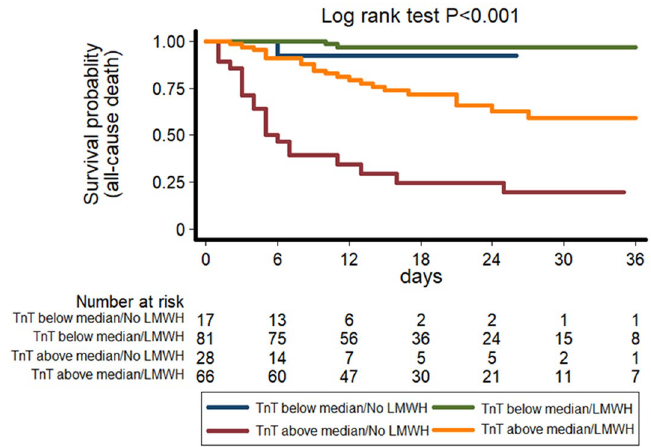
Figure 2. Kaplan–Meier survival curves for all-cause death according to hsTnT levels above and below median and the presence or absence of heparin treatment during hospitalization (green line = TnT below median, heparin; blue line = TnT below median, no heparin; orange line = TnT above median, heparin; red line = TnT above median, no heparin). TnT: Troponin T; LMWH: Low Molecular Weight